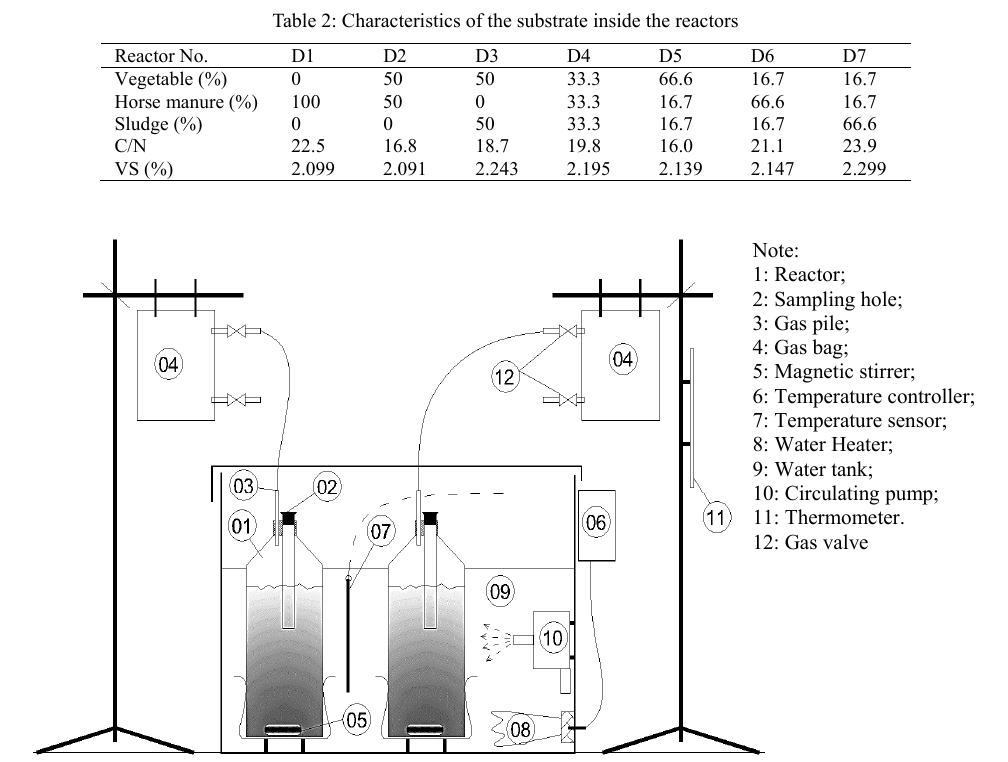
Fig. 1: Diagram of the experiment